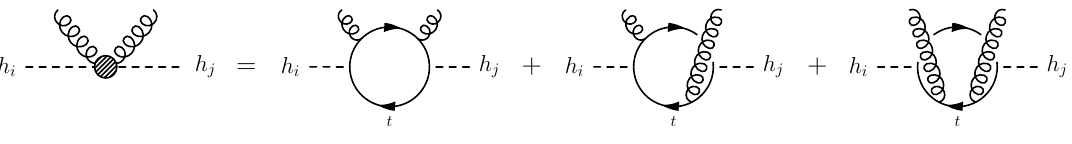
Figure 4 . Higgs correlation